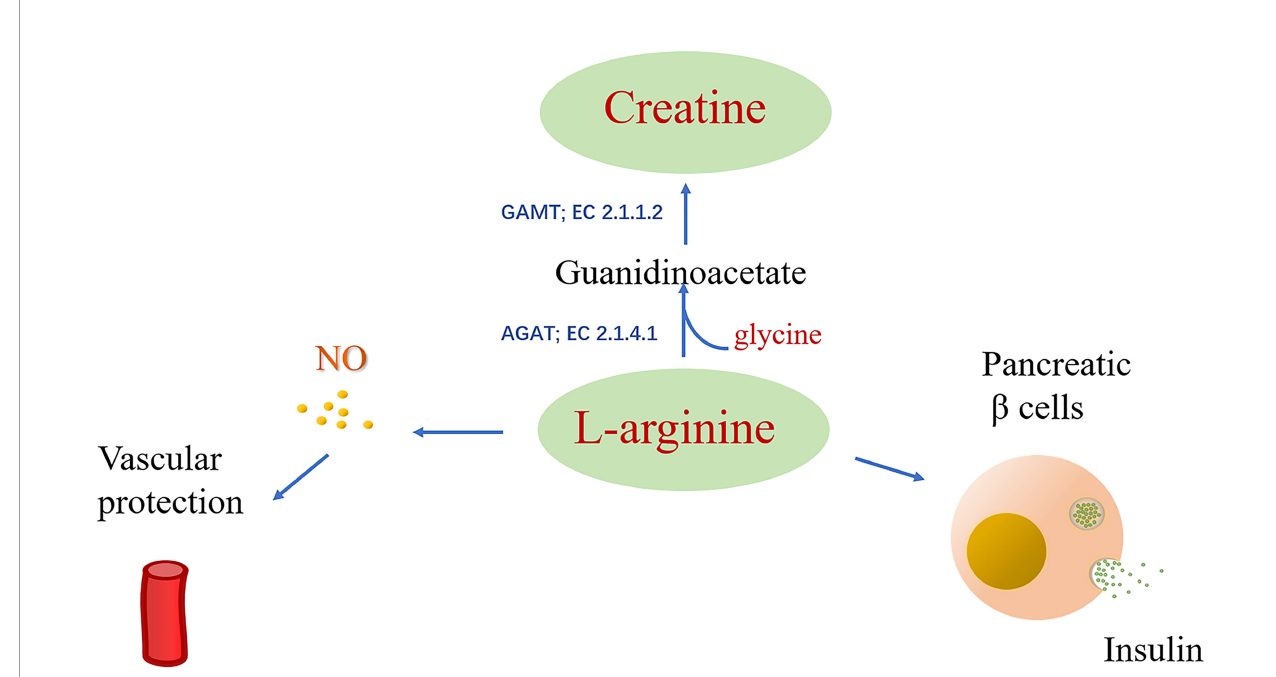
FIGURE 3 | Arginine is catalyzed by the substrate of nitric oxide synthase (NOS) to produce NO, and arginine can induce the release of insulin from pancreatic b